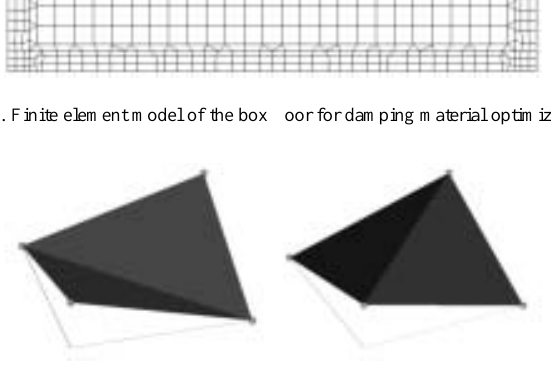
Fig. 4. Geometries associated to a square element with two opposite nodes